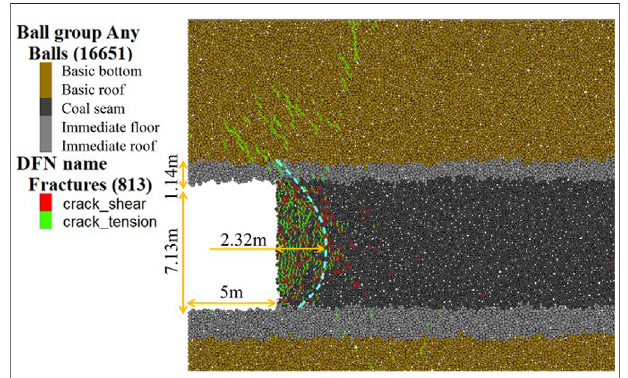
FIGURE 11 | Fracture propagation form of full height mining at one time after stress debugging.